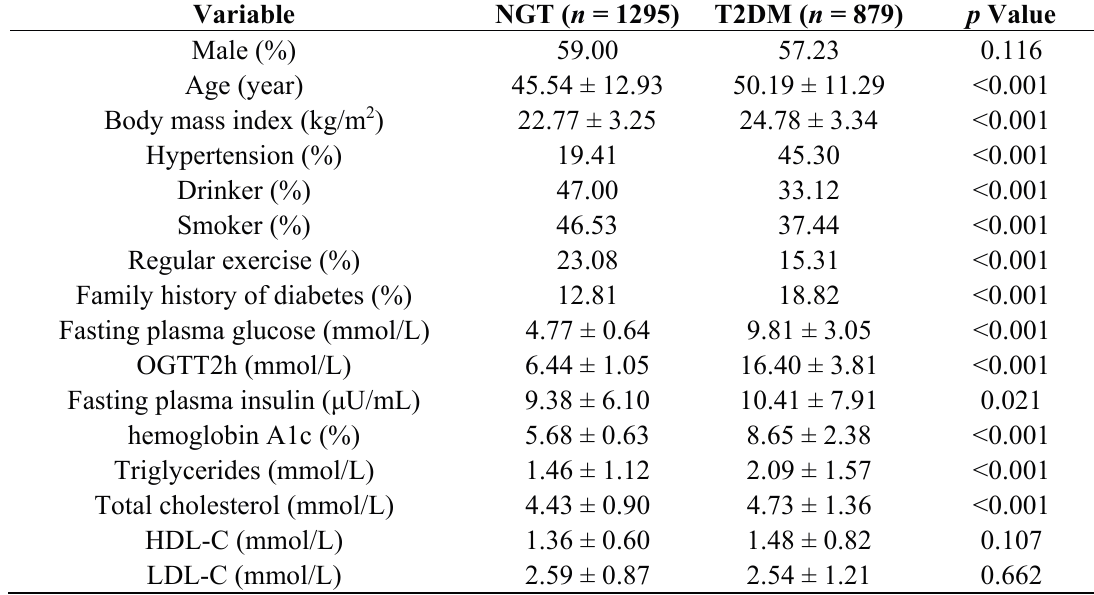
Table 1. Anthropometric and biochemical characteristics of the study